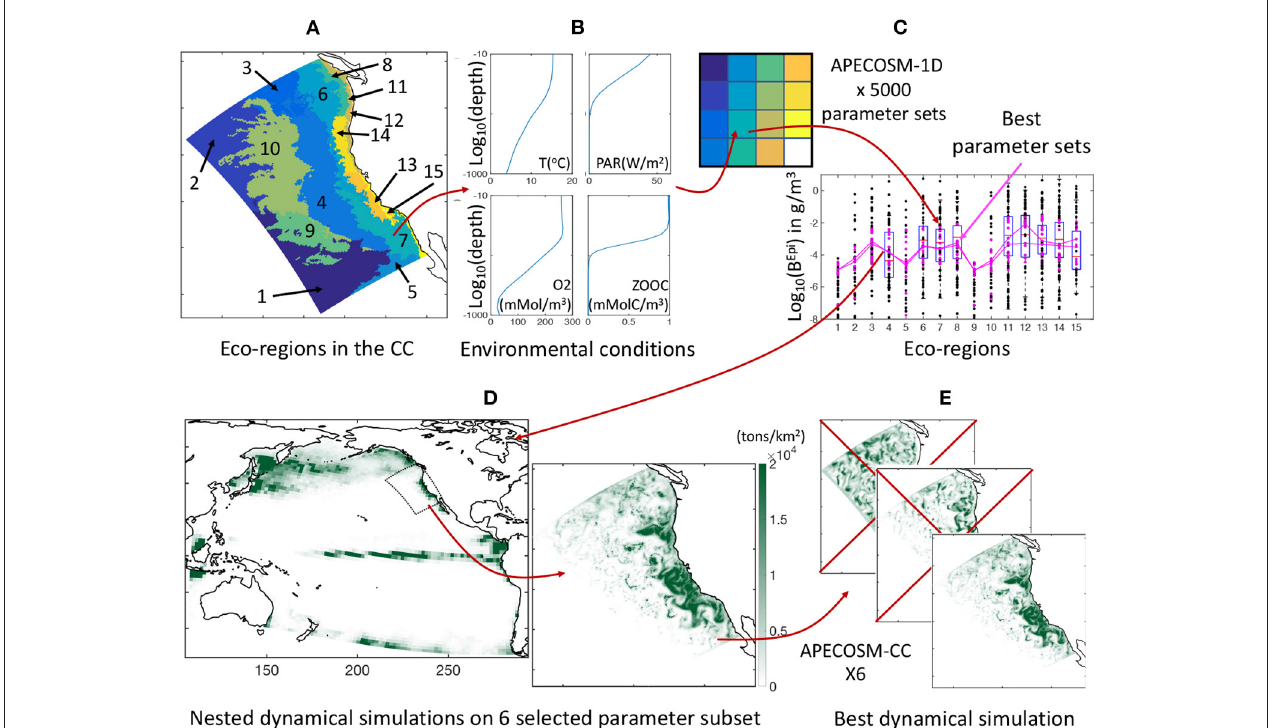
FIGURE 3 | Schematic of the optimization approach. (A) Eco-regions of the California Current used as independent stations for model tuning. (B) Illustration of averaged vertical profiles used to force the model in each station, here station # 7. (C) Illustration of the Monte Carlo procedure, whereby each eco-region is reduced to a single grid cell in APECOSM-1D, 5,000 replicates of this 1D configuration are run, and optimal parameter sets are selected by comparison with observations. (D) Illustration of the parent Pacific and nested California Current 3D dynamical simulations. (E) Selection of the best regional 3D dynamical simulation from six optimal simulations with different parameter